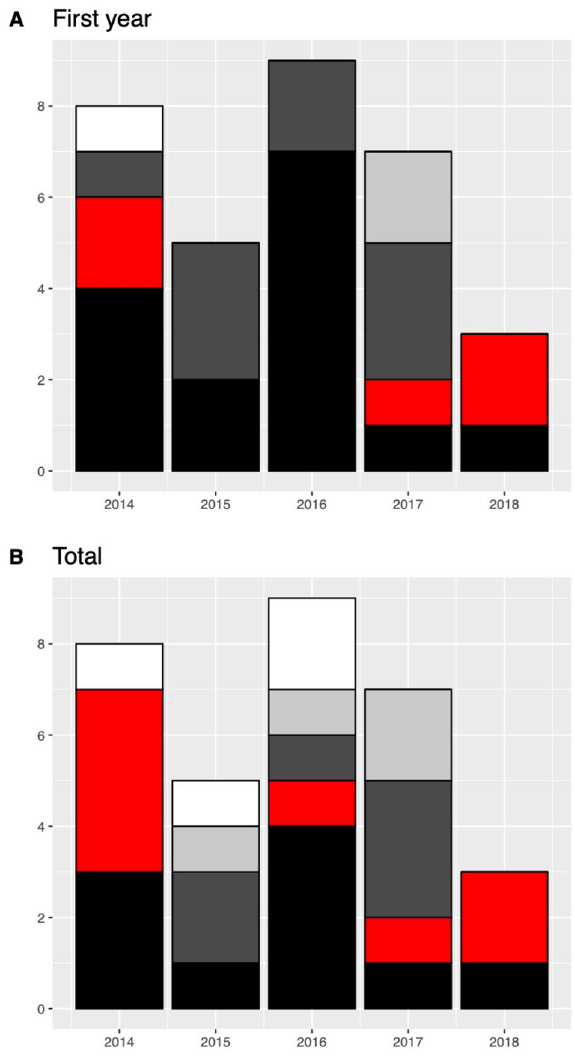
Figure 5. Status of the reintroduced lynx during the first year after release ( A ), and at the end of the study period ( B ). Five different statuses are shown: resident at the reintroduction area (black); found dead (red); dispersed to another area (dark grey) translocated to another area (light grey); and disappeared (white).